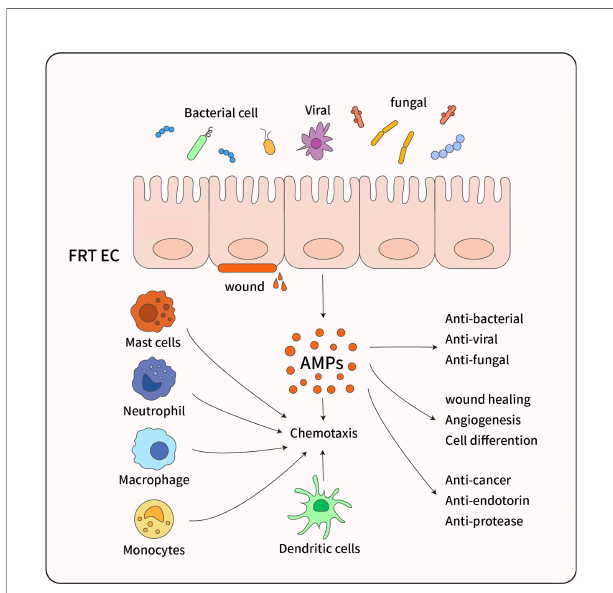
FIGURE 3 | The pleiotropic functions of antimicrobial peptides. AMP have diverse biological effects, which are mainly secreted by female reproductive tract epithelial cells (FRT EC) following exposure to in fl ammatory or microbial stimuli. AMP have a broad spectrum of activity against bacteria and exhibit anti-fungal and antiviral activity, And AMP promote wound healing and angiogenesis through triggering cell differentiation, ultimate tissue homeostasis is maintained. Although AMP are most recognized for their microbicidal and anti-in fl ammatory function, AMP also possess immunomodulatory properties through activation of Mast cells, Monocytes/Macrophages, Neutrophils, and Dendritic cells, and inducing chemotaxis to infection